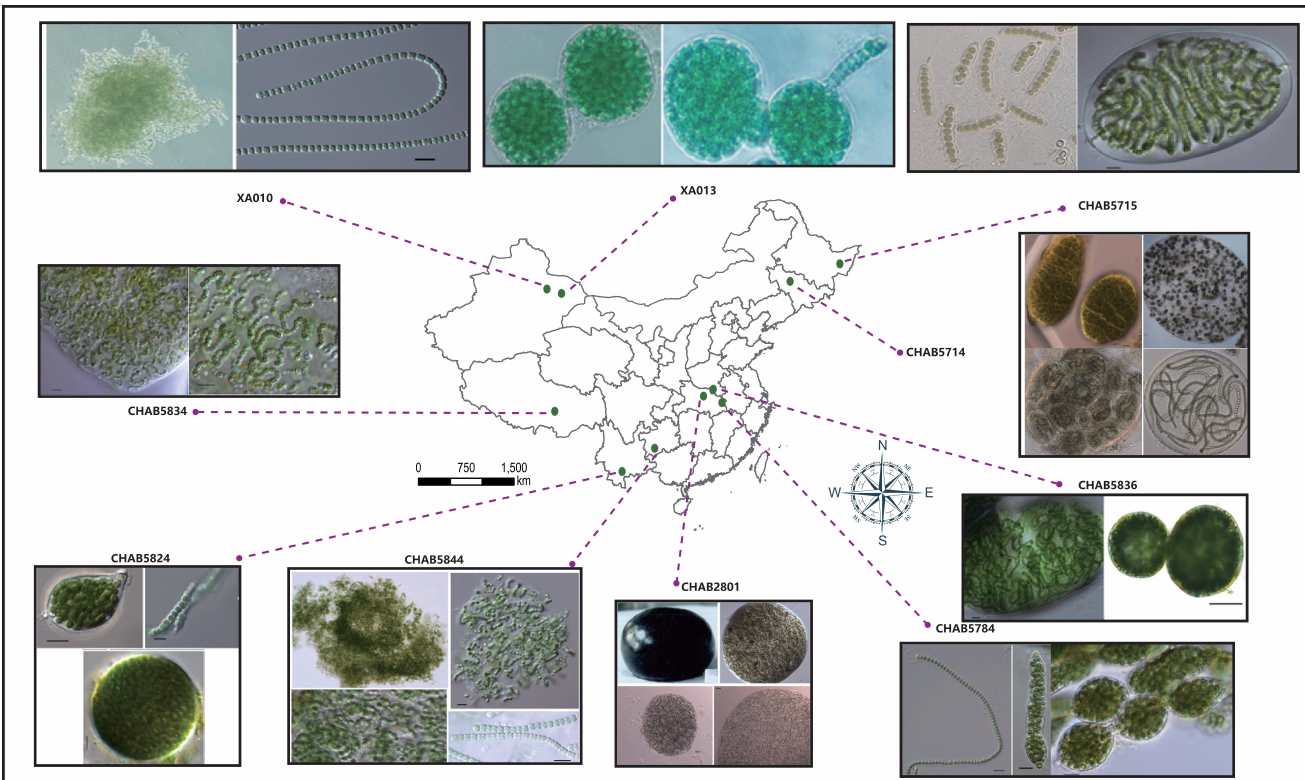
Figure 1. Geographical description of the isolation site. Violet dashed line linked the picture shows the morphological characteristics of each cultured strain.